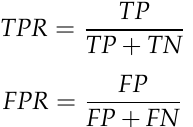
Figure 9. Current waveform in normal and arc fault conditions.